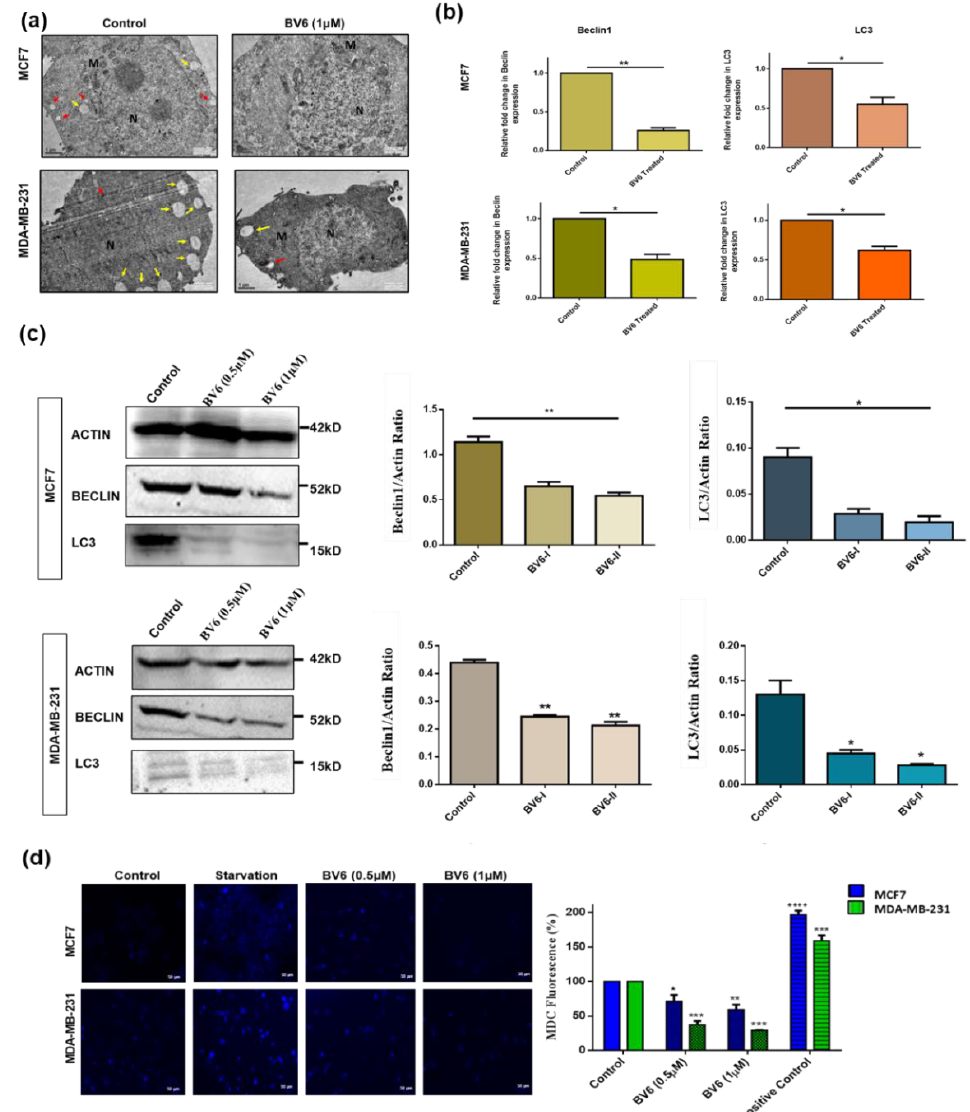
Figure 4. Autophagy in MCF7 and MDA-MB-231 cells treated with BV6: ( a ) TEM images show a normal double-membrane nucleus surrounded with normal-appearing mitochondria along with accumulated autophagic vacuoles such as autophagosomes and autolysosomes. M represents mi- tochondria and N represents the nucleus. ( b ) The relative fold change in Beclin-1 and LC3 mRNA expression levels normalized by Actin in both breast cancer cell lines. ( c ) Western Blot images show- ing the protein bands of untreated control and treated breast cancer cells with 0.5 µ M and 1 µ M of BV6. Histogram displaying the change in the Beclin-1 and LC3 protein expression levels normalized by Actin. ( d ) Fluorescence images captured from fluorescence microscopy of MDC staining showing autophagic vacuoles or autophagosome accumulation in untreated (control), starved cells (Positive control) and BV6 treated cells. Histogram profile representing the mean fluorescence intensity of BV6 treated MCF7 and MDA-MB-231 compared to the fluorescent intensity of untreated control and positive control. BV6-I represents BV6 (0.5 µ M), and BV6-II represents BV6 (1 µ M) in the histogram profile of Western blot. The experiments are carried out in triplicates displayed as mean ± SEM, and the data represented is statistically significant, (*), (**), (***), and (****) show p < 0.05, p < 0.01, p < 0.001, and p < 0.0001